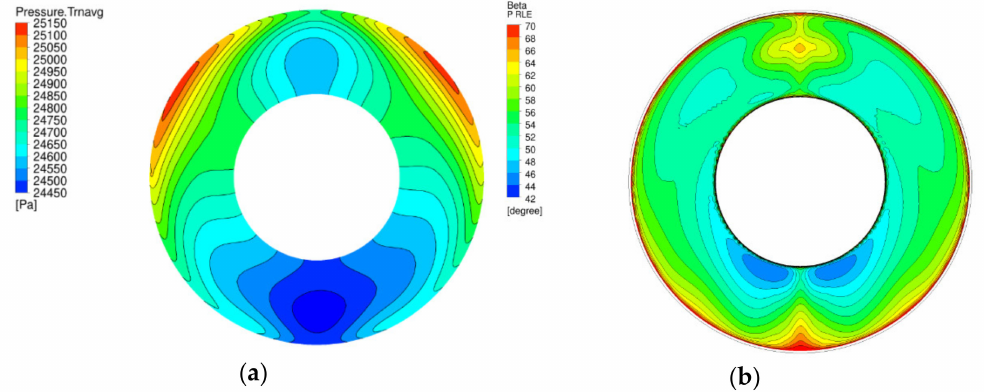
Figure 6. Axial case variation 1 axial chord upstream of the rotor leading edge. ( a ) Static pressure variation; ( b ) relative whirl angle.